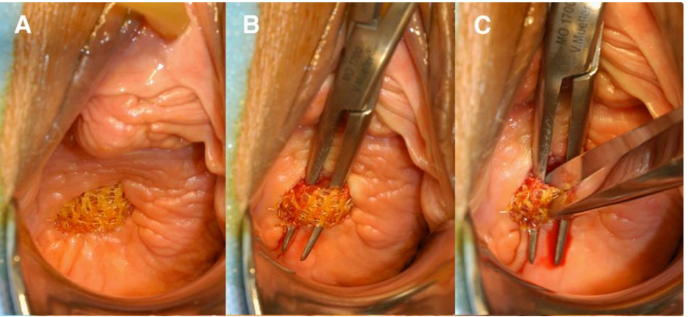
Figure 4. ( A ) Anterior vaginal wall with mesh exposure; ( B ) undermining the mesh; ( C ) transecting the mesh. Reprinted with permission from Margulies et al. (2012) [34]. Copyright Elsevier,